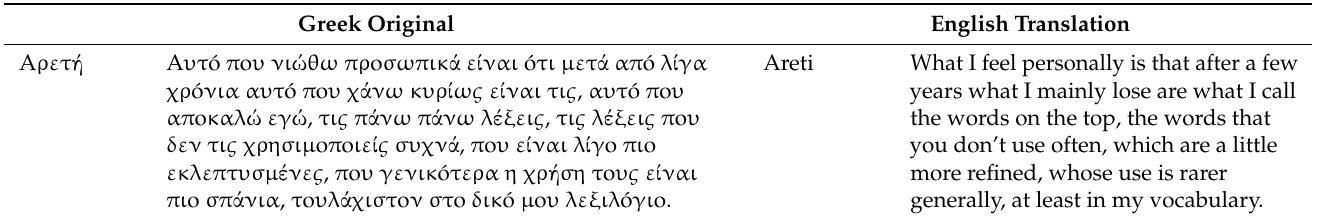
Table 1. “Words on the top”.